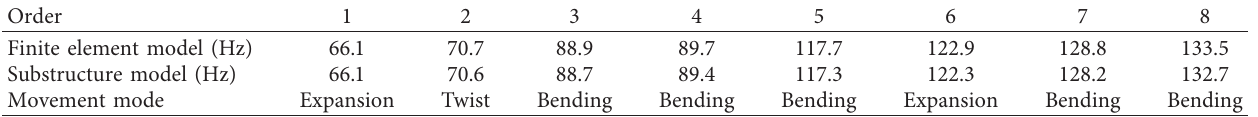
Table 4: The constrained modes of the coil